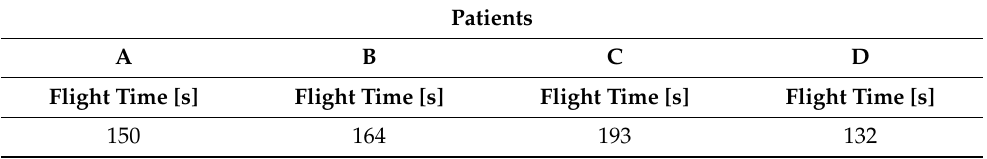
Table 3. Results of the patients’ flight times in the preliminary indoor experiment.